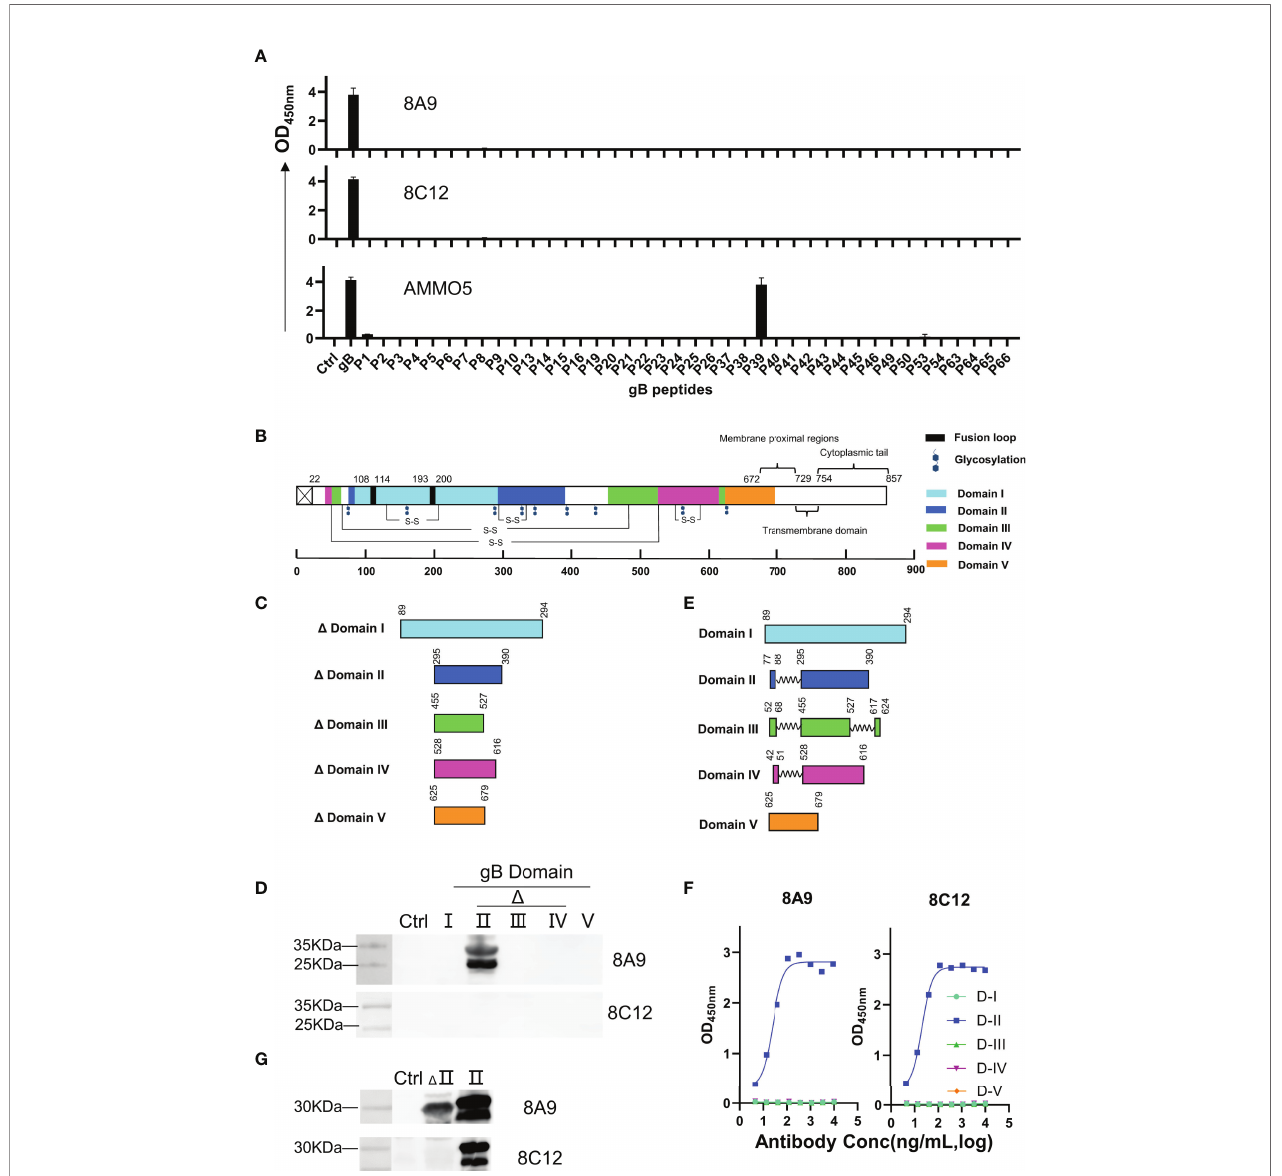
FIGURE 4 | Epitope identi fi cation of 8A9, 8C12, and AMMO5. (A) Epitope mapping using a gB truncated peptide library covering gB ectodomain (aa 23 – 692). Each peptide was 20 amino acids long with a 10-amino-acid overlap in the peptide library. (B) Schematic representation of gB domains, fusion loops, and putative glycosylation sites located on EBV gB. Fusion loop is colored in black. Glycosylation sites were marked as hexagons. gB D-I to D-V were colored cyan, blue, green, magenta, and orange, respectively. (C, E) Graphical representation of (C) truncated domains and (E) complete domains. (D) Western blot analysis of 8A9 and 8C12 for their reactivities with truncated gB domains expressed by E. coli . HBc149 vector was used as control. (F) ELISA analysis of 8A9 and 8C12 for their activities with puri fi ed complete gB domains expressed by 293F cells. (G) 8A9 and 8C12 were tested by Western blot assay for reactivity against truncated and complete D-II. HBc149 vector was used as